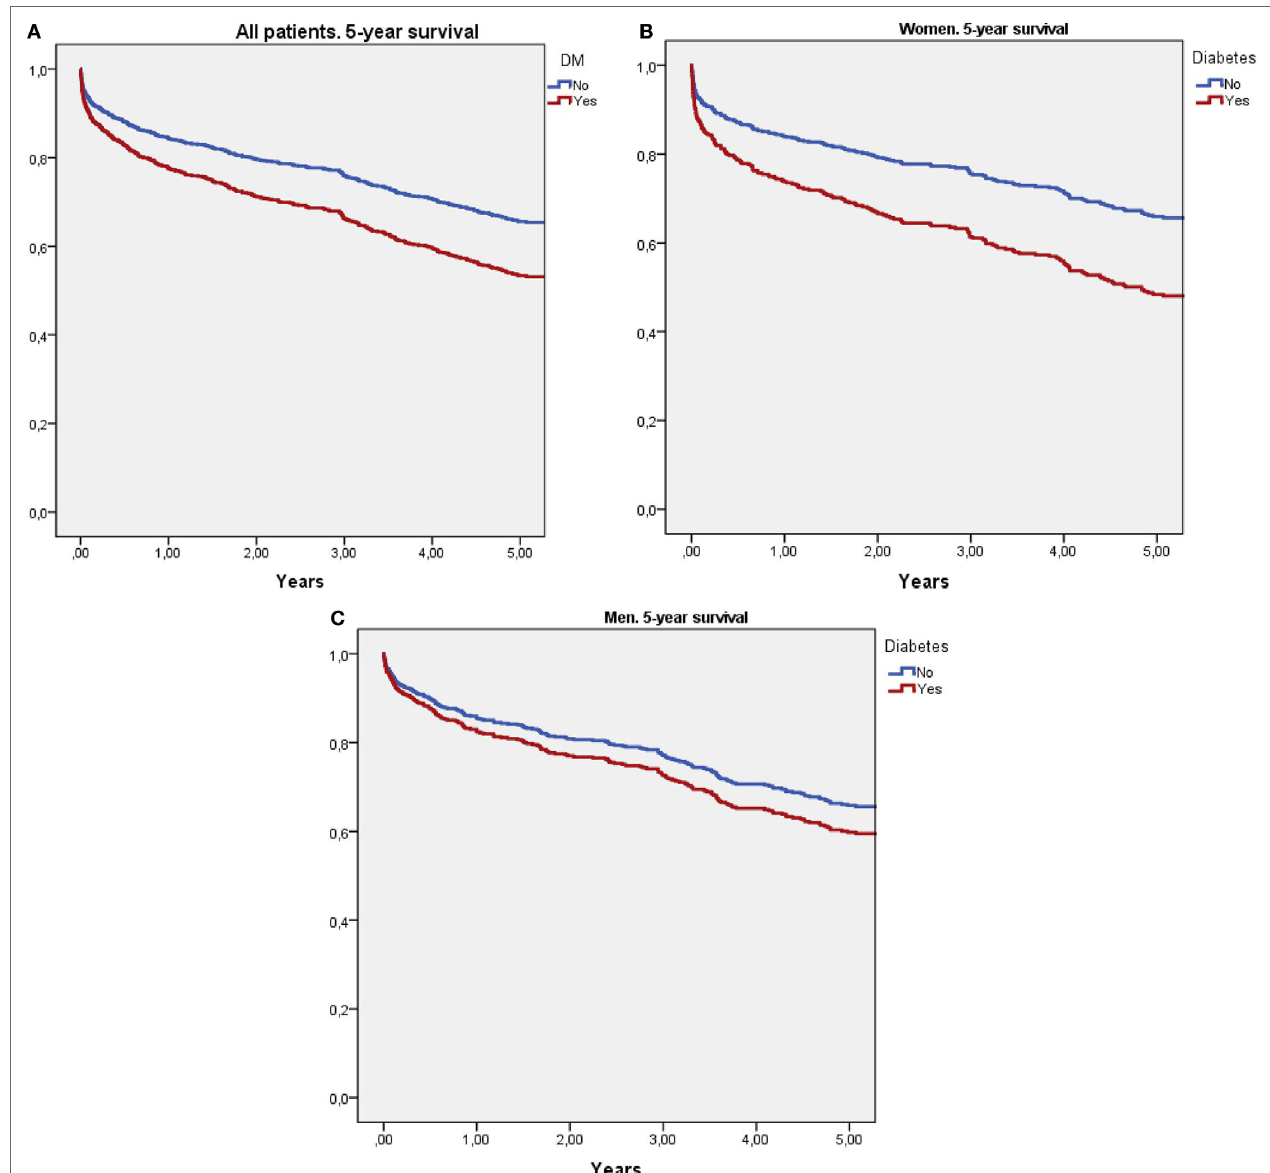
FigUre 1 | Survival curves using Cox regression analysis adjusted for age, stroke severity (National Institute of Health Stroke Scale), and previous modified Rankin Scale score. (a) Compares 5-year survival between diabetic and non-diabetic patients. (B) Compares 5-year survival between diabetic and non-diabetic women. (c) Compares 5-year survival between diabetic and non-diabetic